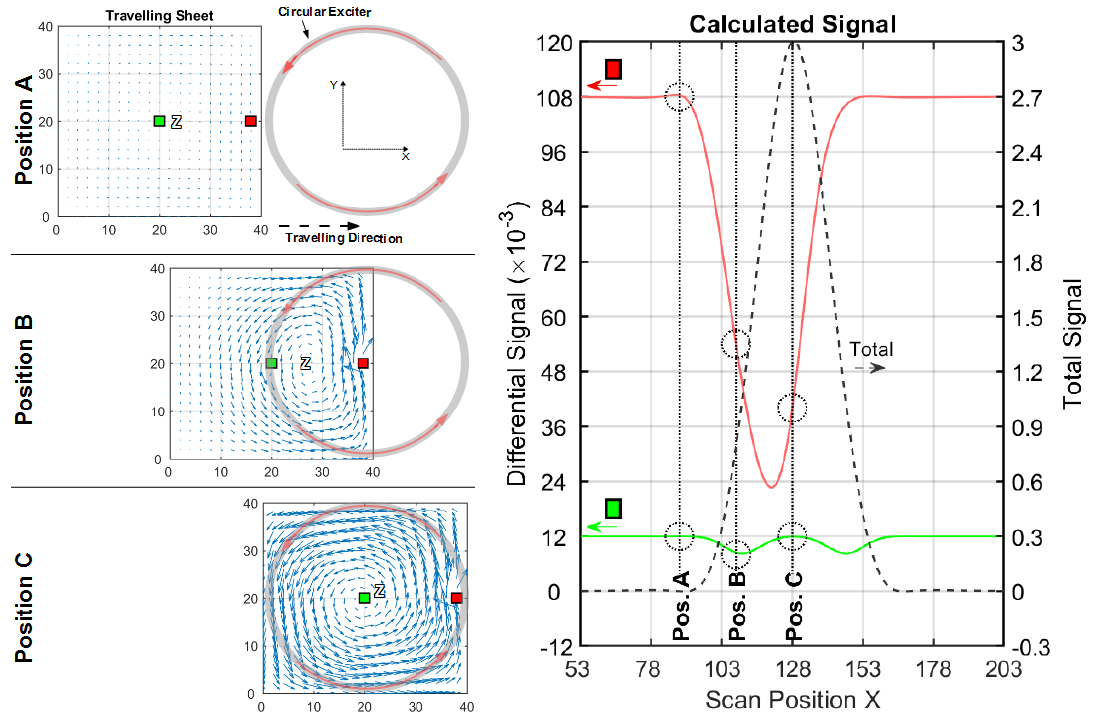
Figure A6. Current and signal calculations with coaxial exciter and receiver coils; ( left ) Travelling 2D sheet with local voids (green and red squares) in front of a circular exciter. Blue arrows depict the current direction and intensity. Only three significant x-positions (A, B and C) are shown; ( right ) Total (dotted black line) and differential signals for a void in the center (green line) and for a void at the edge (red line).